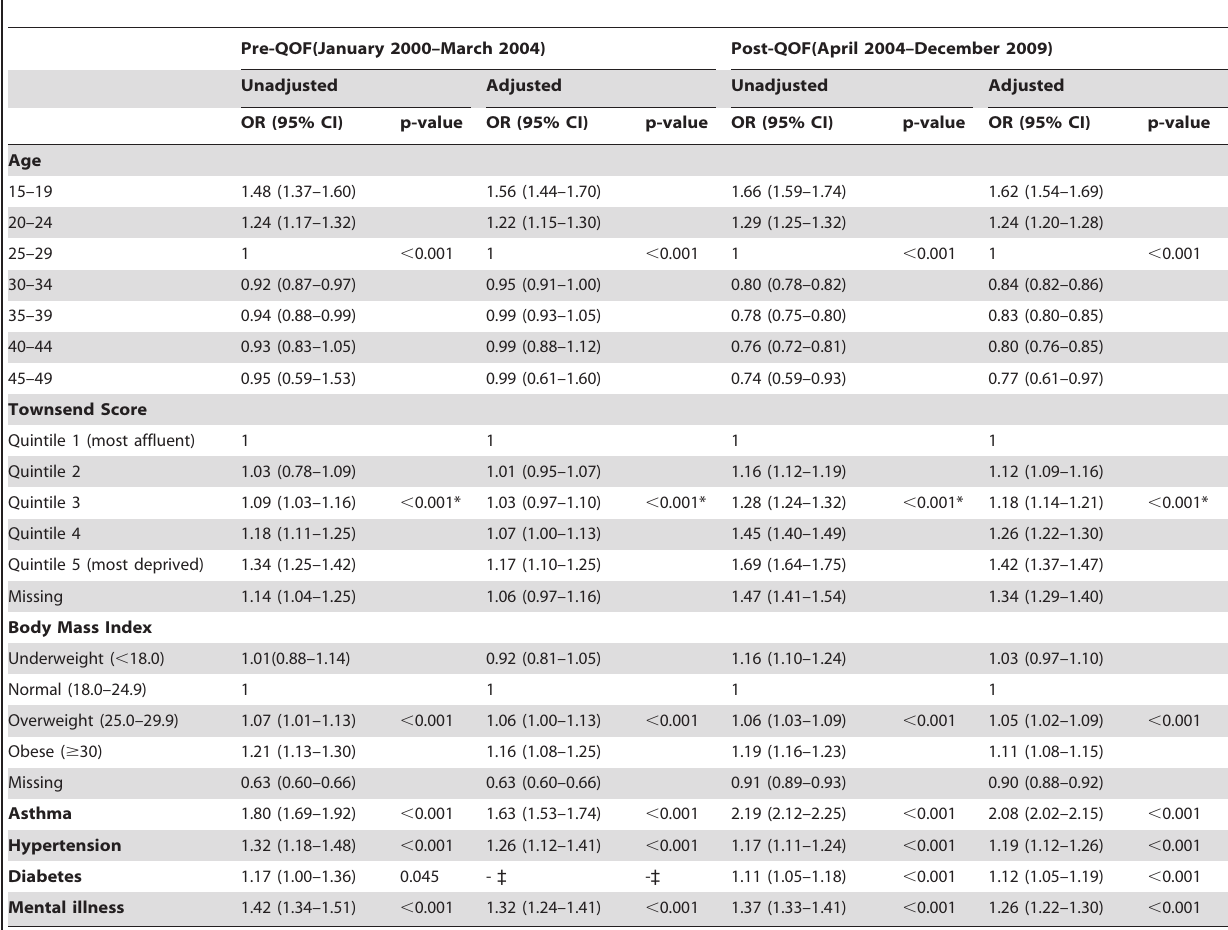
Table 2. Odds of having smoking status recorded during gestation by women’s characteristics before and after the QOF